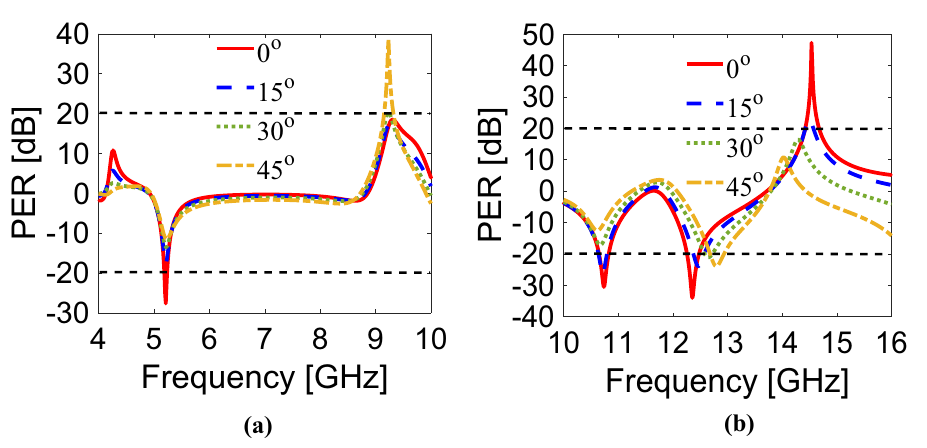
Figure 6. Polarization extinction ratio at different angles for ( a ) y-polarization, ( b )